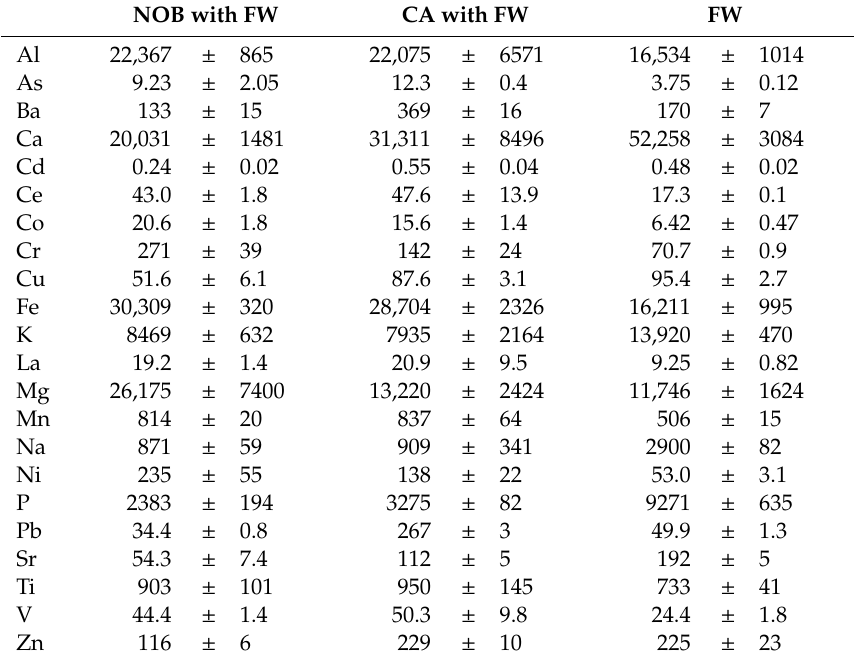
Table 3. Element concentration (mg / kg) ± SD in Campana and Nobile soils, after adding a 30% portion of soil improver (Florawiva (FW)), and in FW, before starting the experimentation (t 0 ).